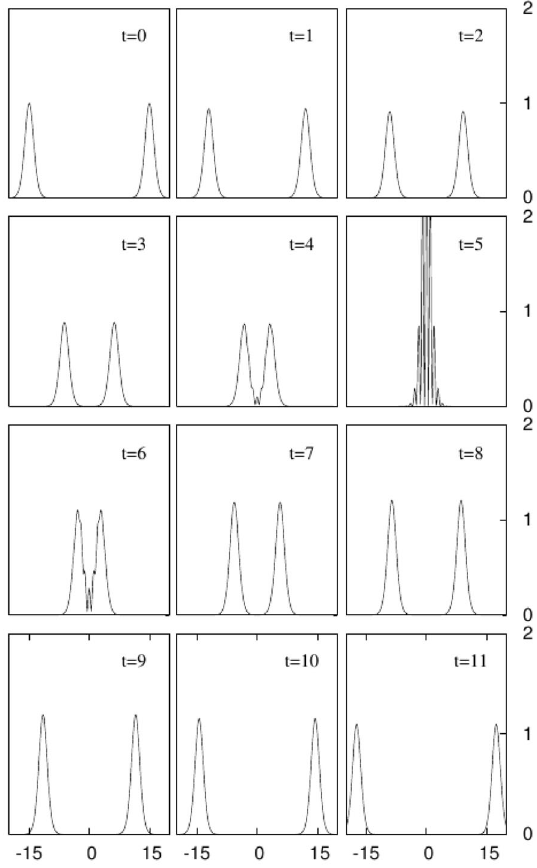
Fig. 21 Collision of identical boson stars with large kinetic energy in the Newtonian limit. The total energy (i.e., the sum of kinetic, gravitational and self- interaction) is positive and the collision displays solitonic behavior. Contrast this with the gravity-dominated collision displayed in Fig.